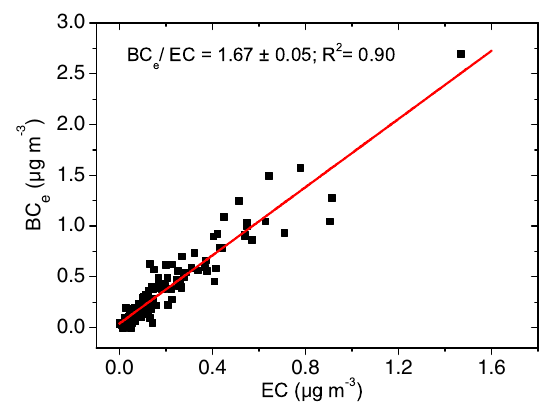
Figure 10. Scatter plot and linear regression between thermal–optical EC and light absorption BC e observed during 19 April 2010–15 May 2012. The BC e / EC slope is 1.67 ± 0.05 with R 2 =